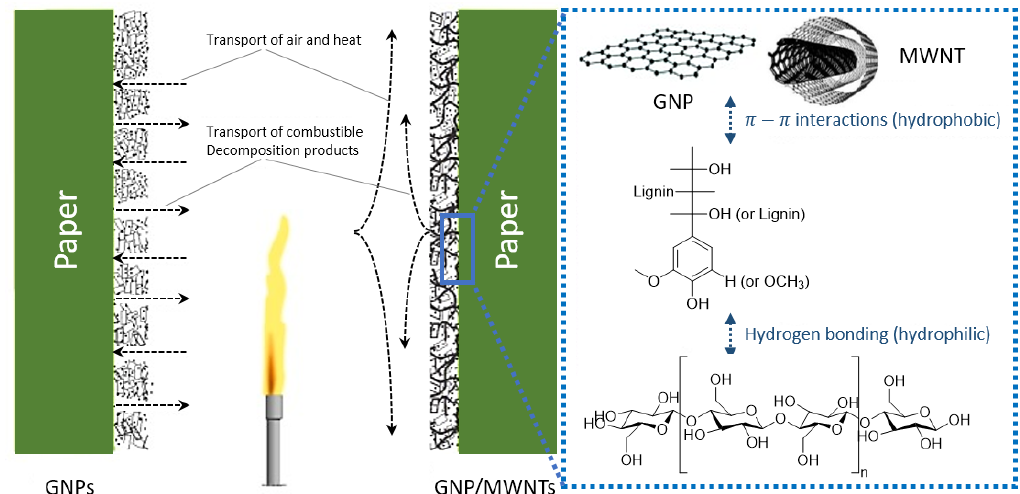
Figure 20. Schematic showing the fabrication of graphene nanoplatelets (GNP)/MWNT/lignin-coated paper using ultra- sonication and rod coating and a flame test of the fabricated paper. Reprinted with permission from Ref. [175]. Copyright 2017, MDPI AG.